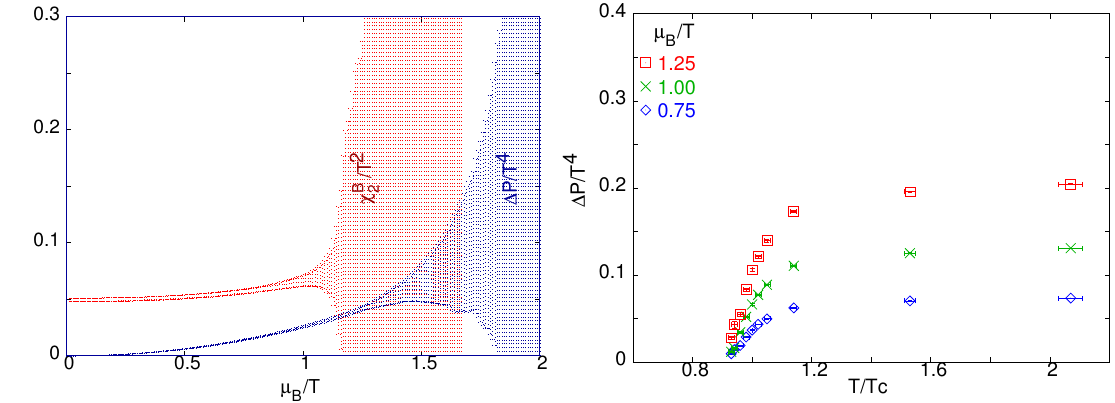
Figure 4. ( left ) The Pade-resummed results for pressure and χ 2 ( right ) ∆ P ( µ , T ) as function of temperature, at various µ B